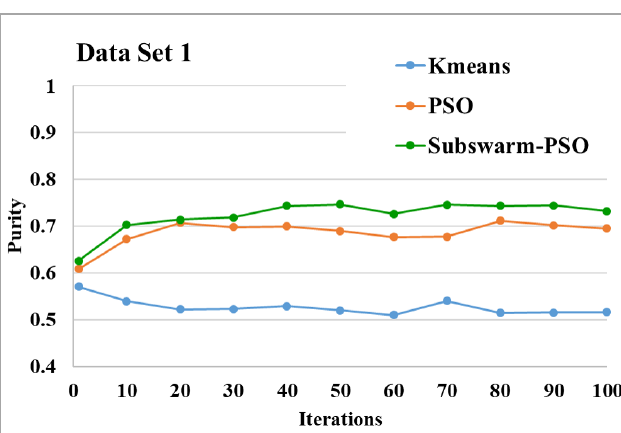
Figure 5. Purity comparison for data set 1.